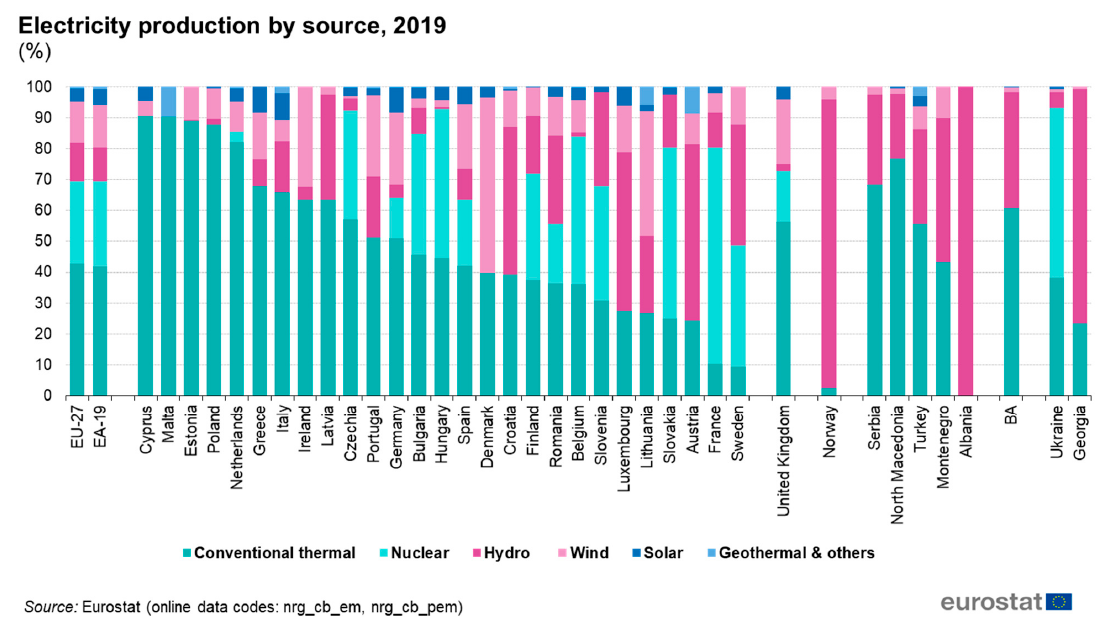
Figure 3. European Union (EU) electricity production mix [49].